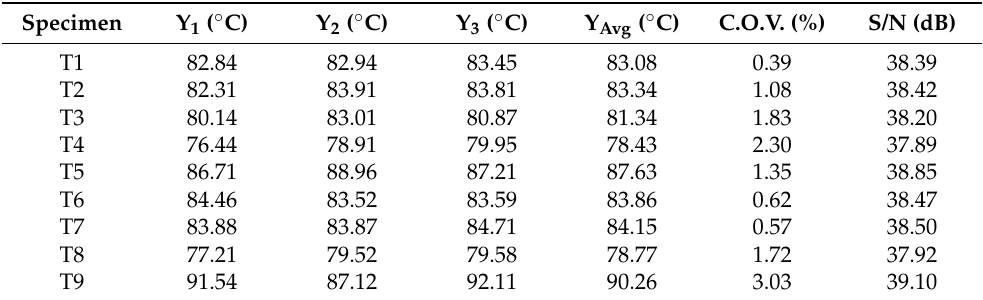
Table 4. Analysis on the measured results of the main glass transition temperature.